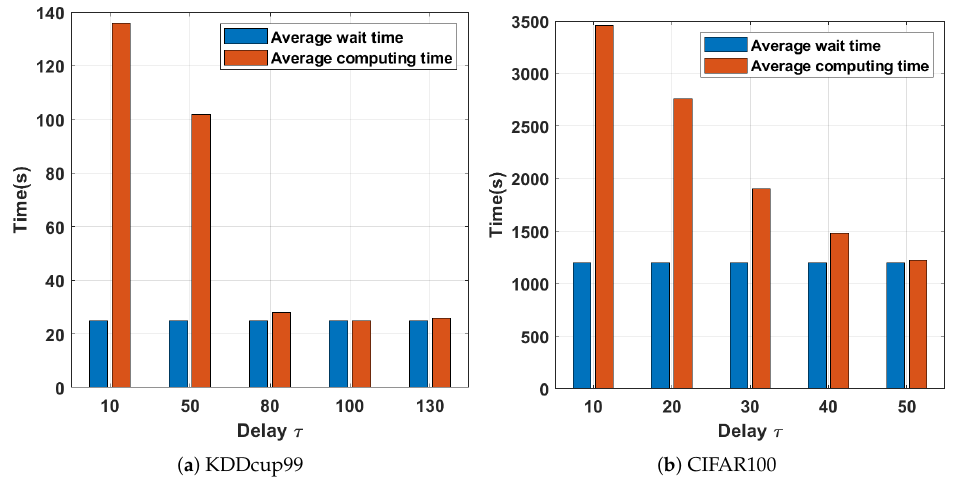
Figure 6. Delay time consumption with different working nodes.